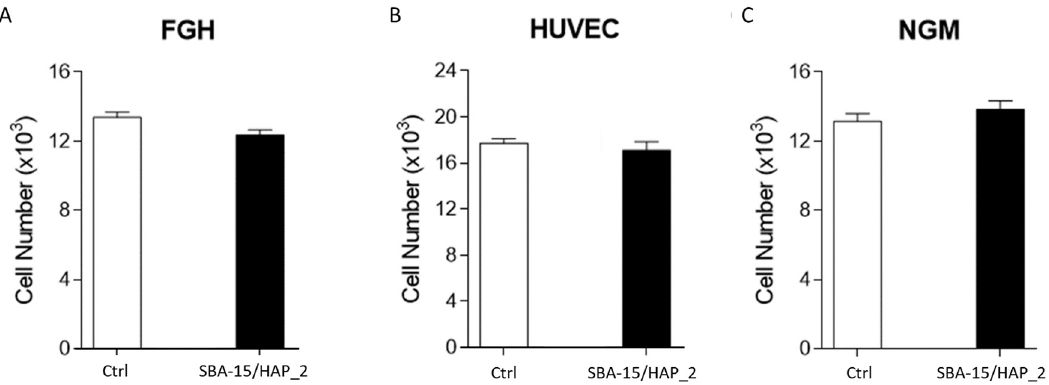
Figure 9. Cytotoxic analysis by MTT of human cells (FGH, HUVEC, and NGM) exposed to SiO 2– CaO–P 2 O 5 mesoporous silica for 24 h. In ( A ) is possible to observe no influence on FGH viability. In ( B ) the presence of SBA-150/HAP_2 showed not influenced the HUVEC cells viability the same has been observed in NGM cells ( C ).